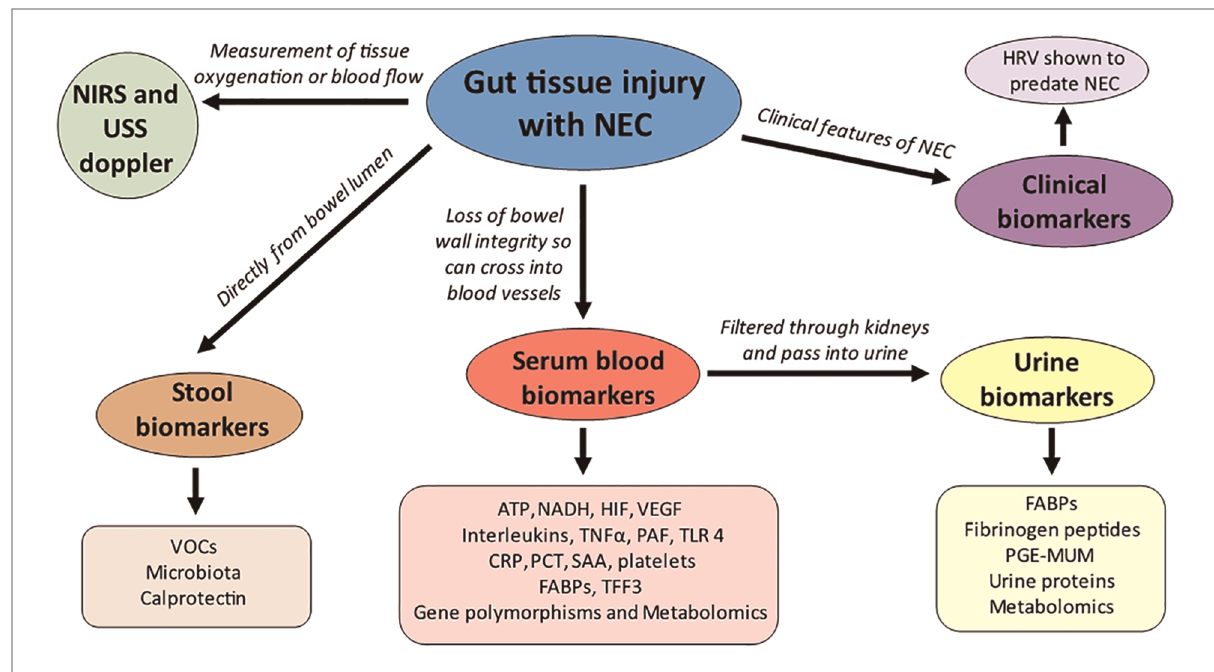
FIGURE 1 Non-invasive gut biomarkers and their origins (sample) of detection. ATP- adenosine triphosphate; CRP- C reactive protein; FABPs- fatty acid binding proteins; HIF-hypoxia inducible factor; NADH- nicotinamide adenine dinucleotide; NIRS- near infrared spectroscopy; PAF- platelet activating factor; PCT- procalcitonin; PGE-MUM- prostaglandin E2 Major urinary metabolite; SAA-serum amyloid A; TFF3- trefoil factor 3;TLR-4 toll like receptor 4; TNF α - tumour necrosis factor alpha; VEGF-vascular endothelial growth factor; VOCs-volatile organic